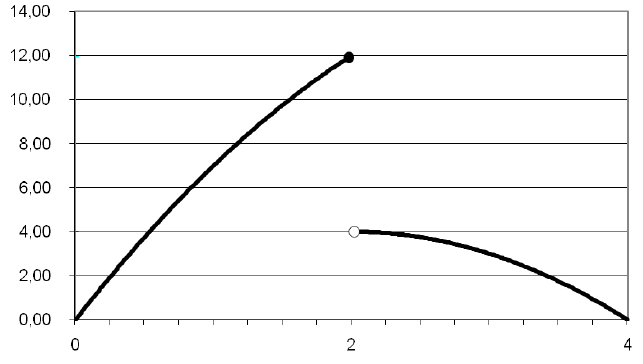
Figure 3. Example 4: Operating profit as a function of